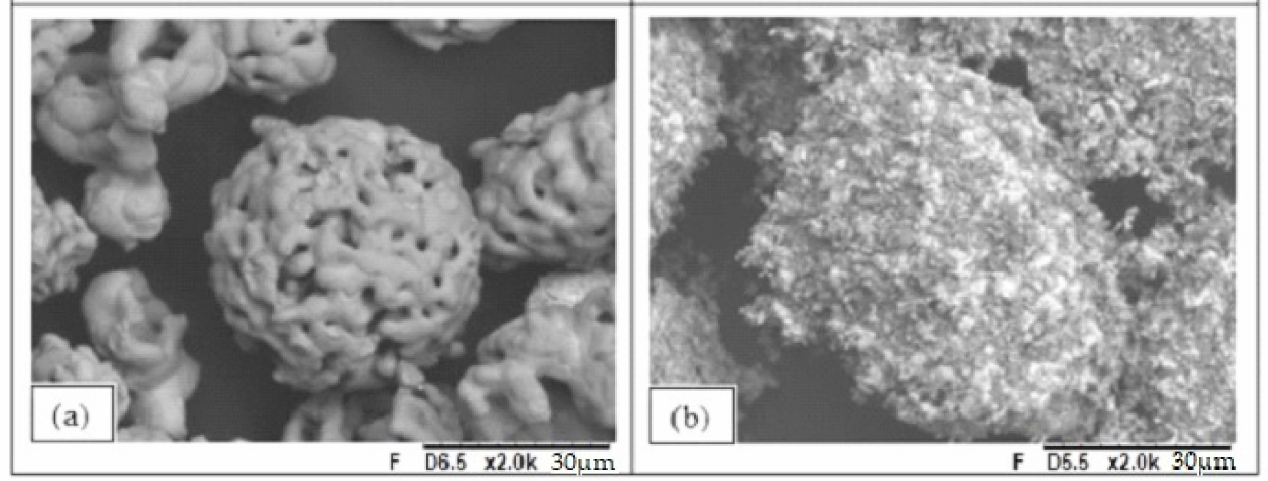
Figure 5. SEM images of ( a ) the original spraying powder and ( b ) after HEM spraying powders. Figure 6 exhibits the SEM image of the mixed powder group. The original particles are surrounded by the milled particles.